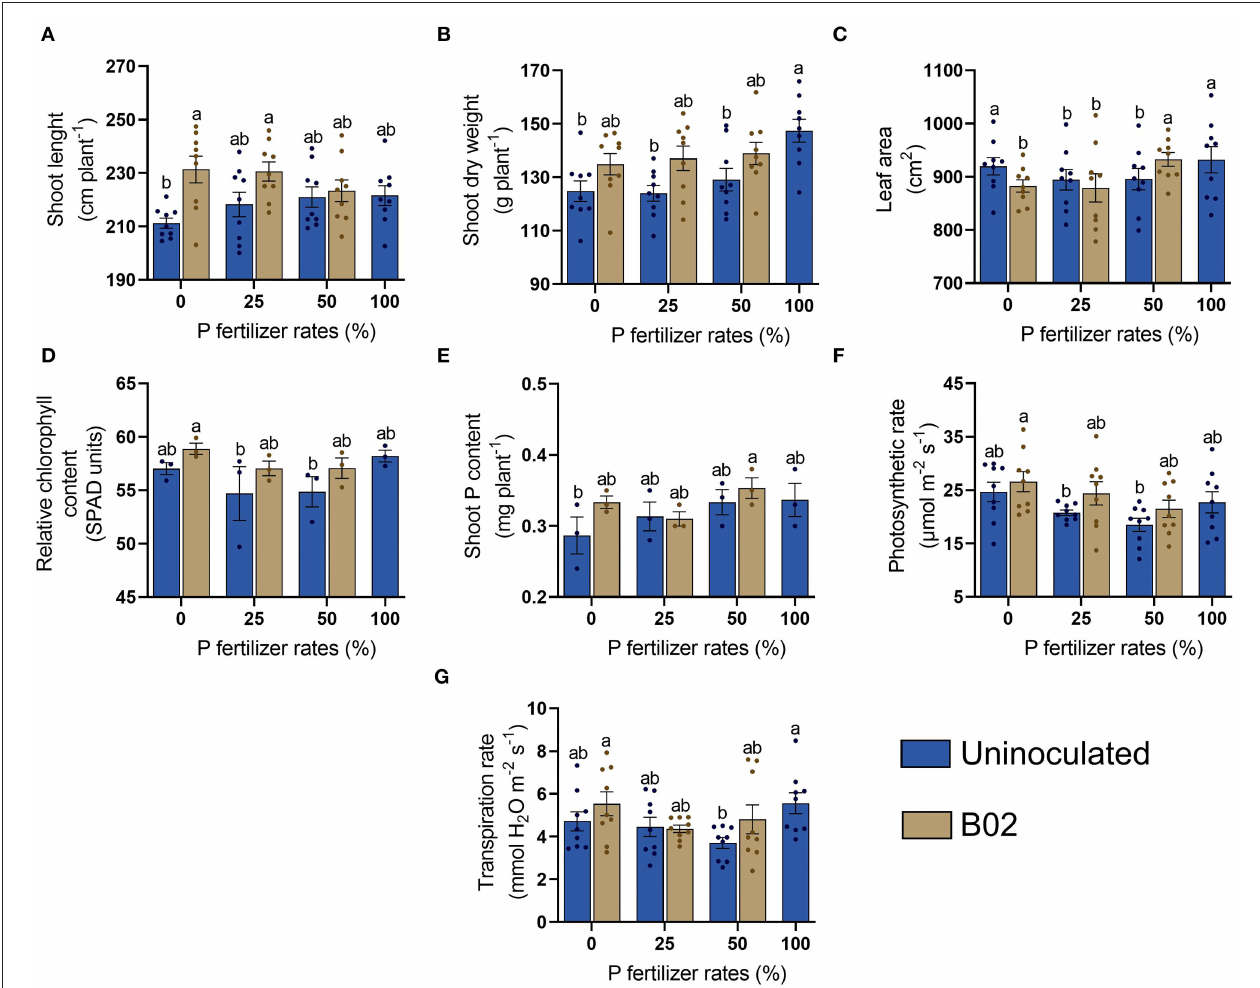
FIGURE 2 | Influence of inoculation with Rhizobium sp. B02 on shoot length (A) , shoot dry weight (B) , leaf area (C) , relative chlorophyll content (D) , shoot P content (E) , photosynthetic rate (F) , and transpiration rate (G) of the white endosperm genotype of maize at the vegetative stage of the tassel (VT). Except for relative chlorophyll and shoot P contents (three measurements), means and standard errors result from three replicates and three independent repetitions (nine measurements). Different letters are indicators of significant differences according to Tukey’s test ( p <